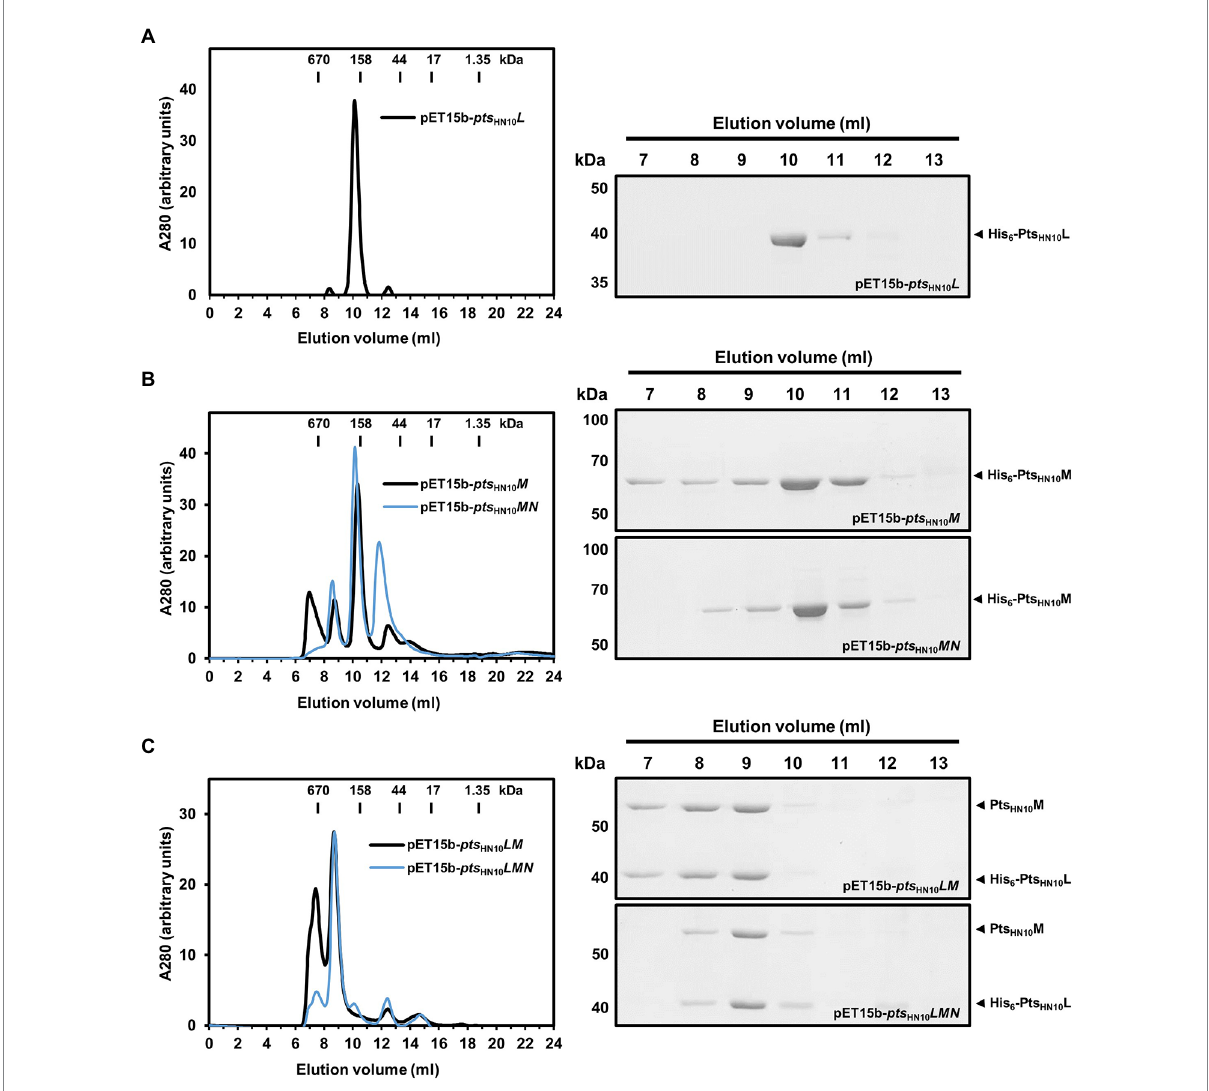
FIGURE 2 Oligomeric state of putative RBPs in solution. (A) Ni-NTA purified proteins expressed from pET15b- pts HN10 L , (B) pET15b- pts HN10 M and pts HN10 MN (C) pET15b- pts HN10 LM and pts HN10 LMN constructs were fractionated on a Superdex 200 Increase column. The bars on the size exclusion chromatography graph indicate the molecular weight of standard gel filtration markers. Elution fractions were collected, concentrated, and analyzed by SDS-PAGE. The His 6 -Pts HN10 L and His 6 -Pts HN10 M are indicated by black